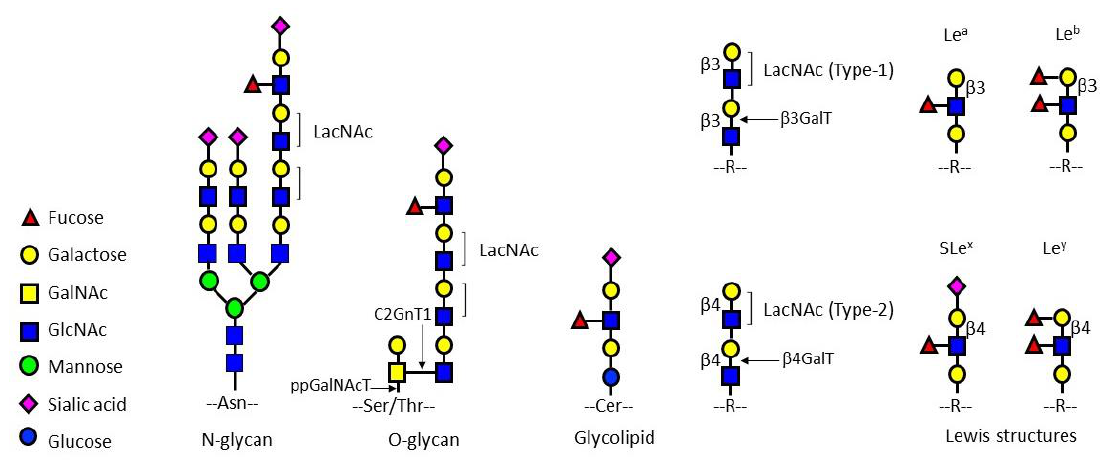
Figure 1. Structures of LacNAc and Lewis epitopes present in N / O -glycans and